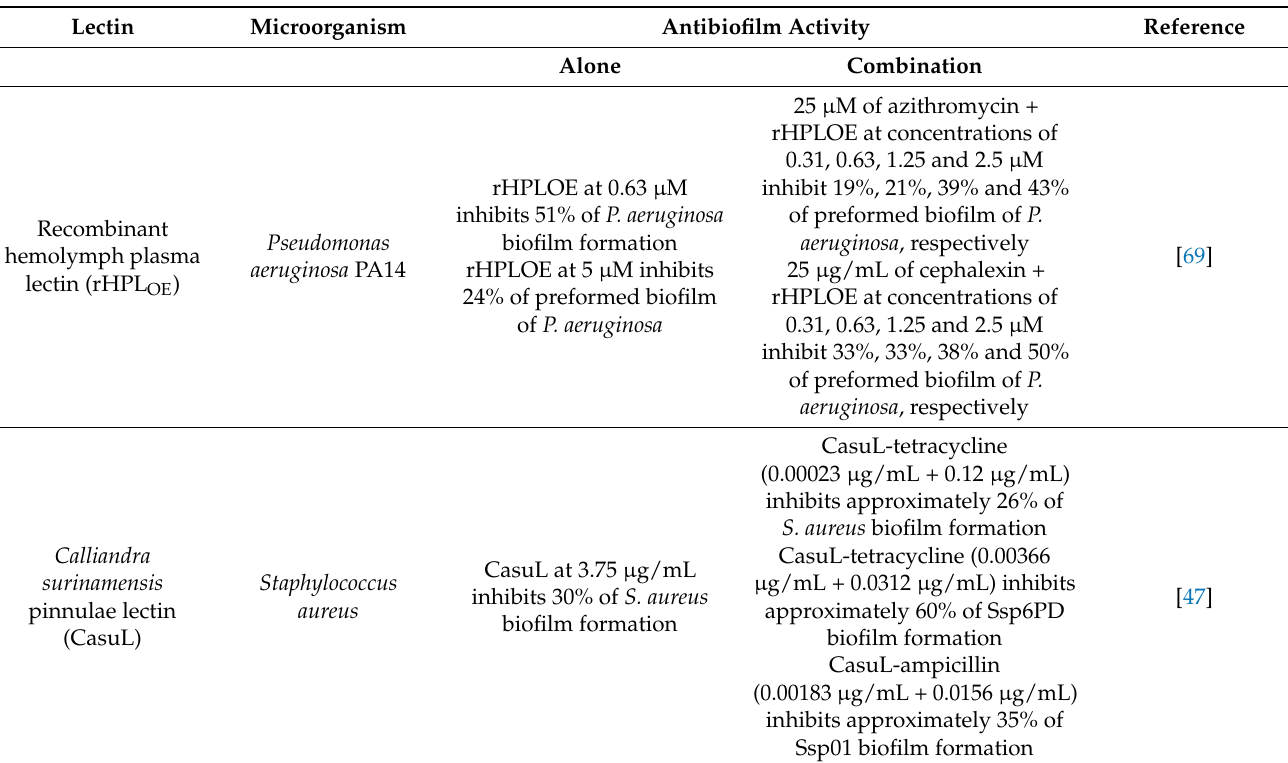
Table 4. Antibiofilm activity of lectins in combination with